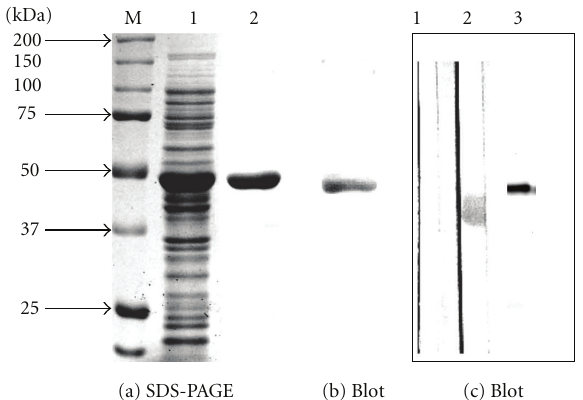
Figure 1: Purification of A. baumannii EF-Tu. Purification of A. baumannii rEF-Tu. (a) Overexpressed (lane 1) and column- purified rEF-Tu (lane 2). (b) Immunoblot of column-purified rEF- Tu with anti-His-tag monoclonal antibody. (c) Immunoblot of A. baumannii cell lysate with rabbit prebleed (lane 1) and anti-rEF-Tu antibodies (2). Immunoblot of rEF-Tu with the anti-rEF-Tu (3).